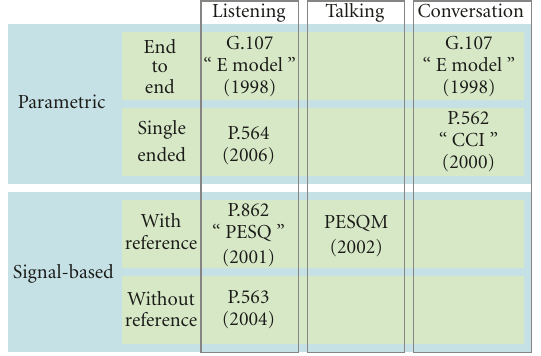
Figure 3: Classification of existing objective methods for speech quality assessment.